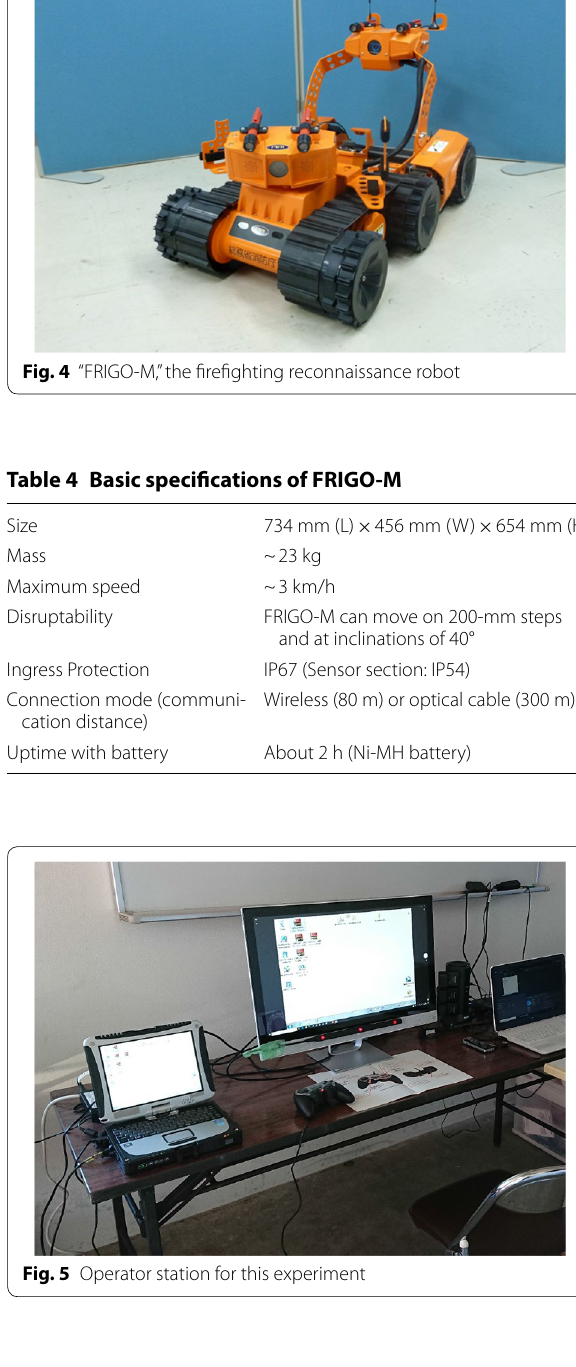
Figure 5 shows the work station of the operator: the lap- top is used to operate FRIGO-M and the PC monitor is used to measure the eye trajectories of participants. Par- ticipants operated this robot using a PC game controller installed on the laptop.